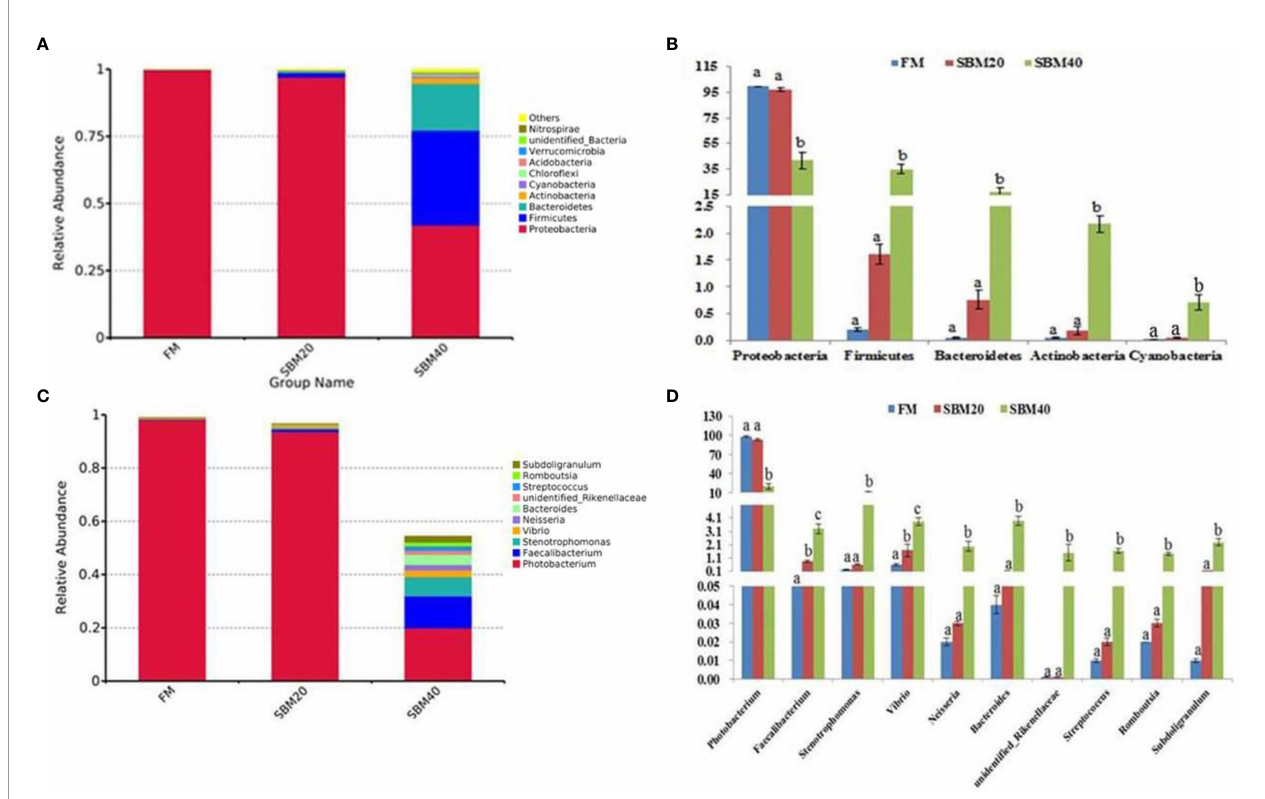
FIGURE 5 | Comparison of bacterial composition and abundance of different soybean meal substitution levels [ (A, B) phylum level; (C, D) genus level] ( n = 3). The different letters represent signi fi cant